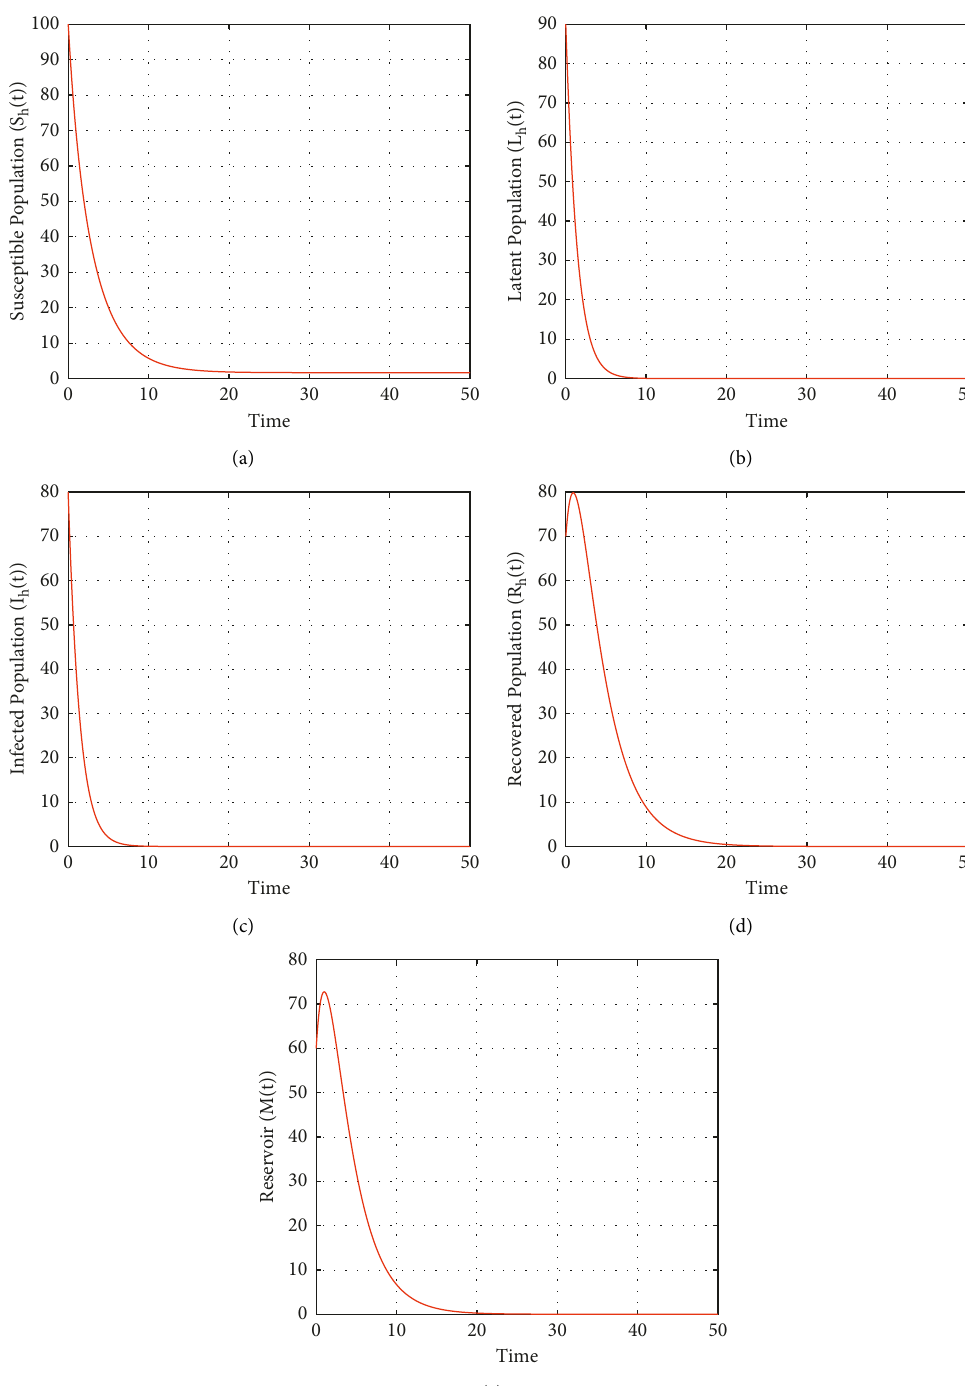
Figure 2: The results visualize the dynamics of the fractional order model around the disease-free state ( X parameters are chosen as: Λ � 0 . 5, β � 0 . 2, η � 0 . 6, and α � 0 . 6. In this case, the value of the threshold parameter is less than unity i.e., R η 1 2 Latent– L h ( t ) . (c) Infected– I h ( t ) . (d) Recovered– R h ( t ) . (e) Reservoir–. M ( t )